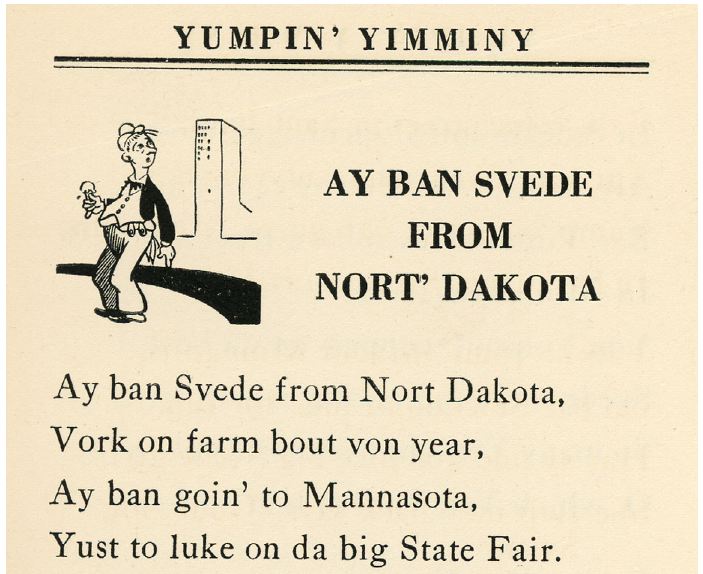
Figure 5: Opening lyrics for George T. Springer’s version of the dialect song “Swede from North Dakota,” published in his 1932 humor anthology, Yumpin’ Yimminy . (Author’s collection).